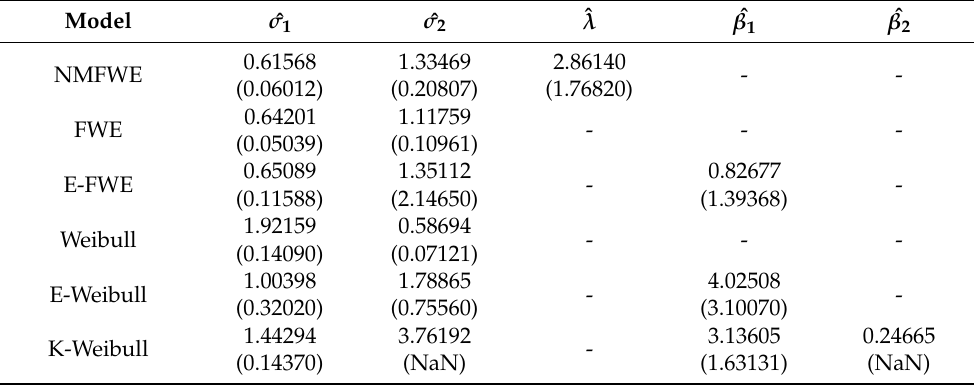
Table 4. The numerical values of ˆ σ 1 , ˆ σ 2 , ˆ λ , ˆ β 1 , and ˆ β 2 , using the first COVID-19